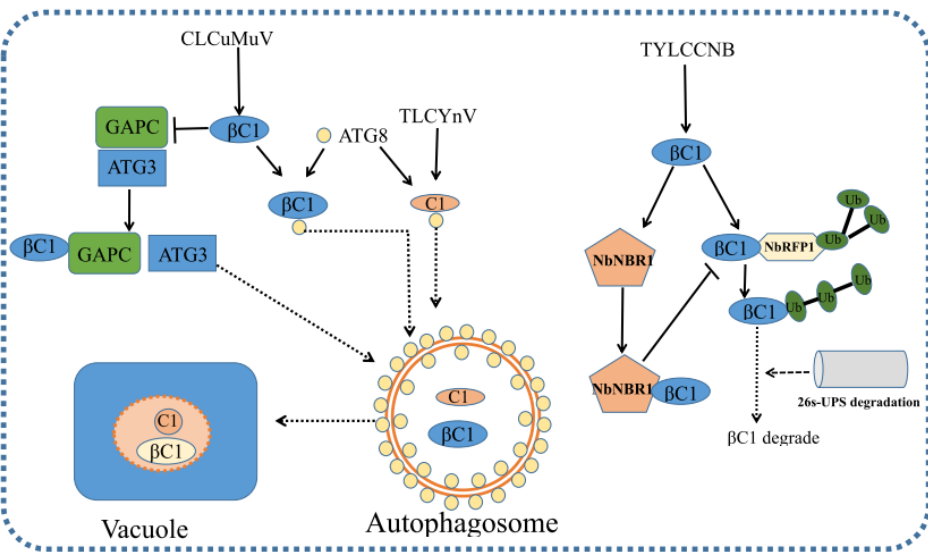
Figure 2. Autophagy in plant–geminivirus infection. CLCuMuB β C1 and TLCYnV C1 interacts with autophagy-related gene 8 (ATG8) protein and are degraded by autophagy. CLCuMuB β C1 bound to GAPCs and disrupted the interaction between GAPCs and autophagy-related protein 3 (ATG3) to induce autophagy. The β C1 of TYLCCNB can be degraded by the ubiquitin 26S proteasome system (UPS) mediated by NbRFP1 in N. benthamiana . In order to successfully infect the host, the viral β C1 protein induces the overexpression of NbNBR1 in the host, and then β C1 forms particles with NbNBR1 in the cytoplasm, which prevent β C1 from being degraded by the UPS system, resulting in an increased accumulation of the βC1 protein in the host cells and many severe symptoms.